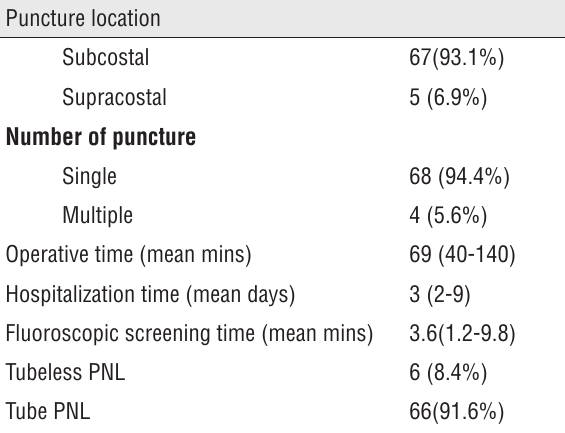
Table 2 - Intraoperative data.